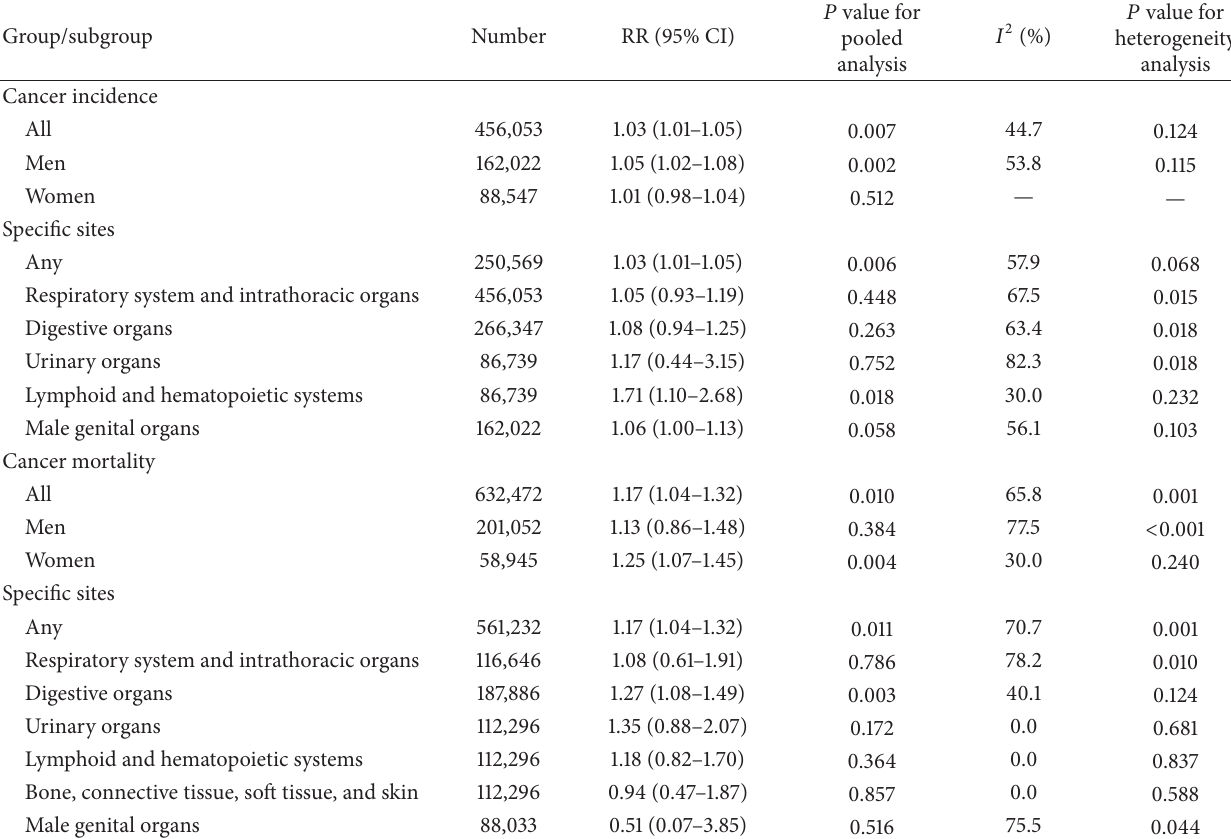
Table 2: Summary meta-analysis results for the association between SUA levels and